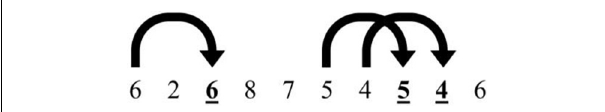
FIGURE 1 | Example of target stimuli (underline numbers) in the visual 2-back